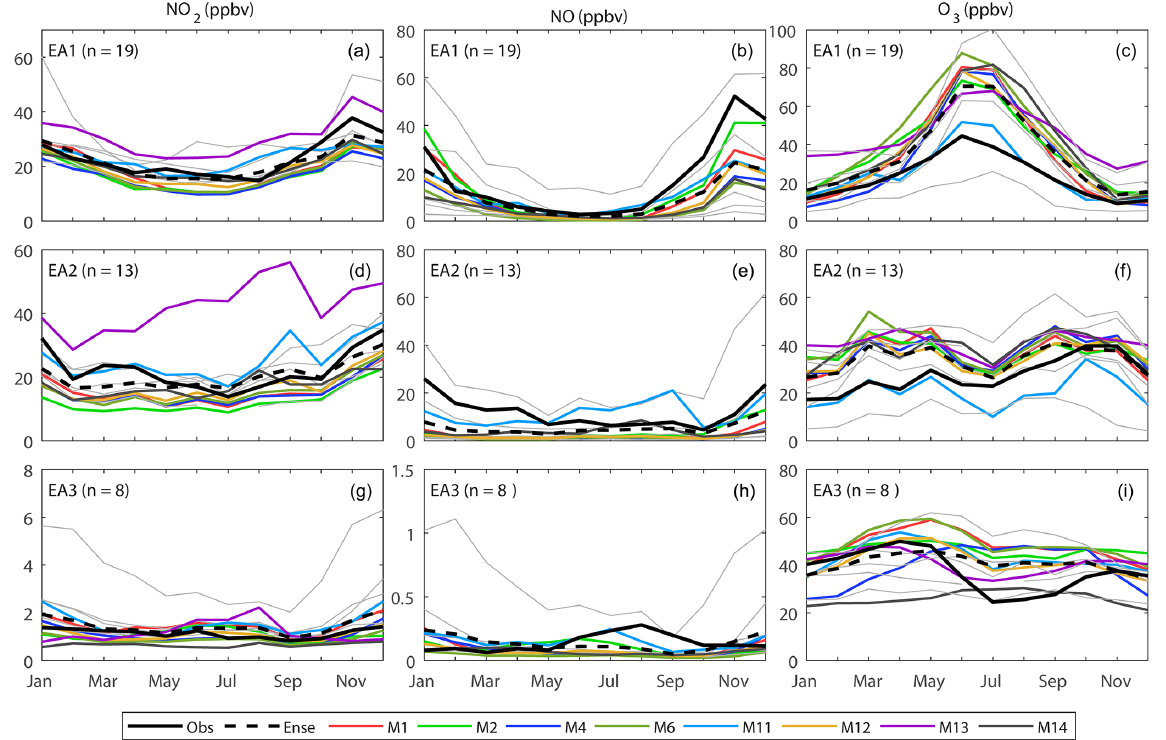
Figure 3. Time series of monthly NO 2 , NO and O 3 levels simulated by all models and their ensembles (Ense) in parts per billion by volume (ppbv), averaged over all observed stations across three subregions of East Asia: EA1 (a–c) , EA2 (d–f) and EA3 (g–i) . Observations are denoted by the solid black line. n represents the number of stations. The gray lines represent NO 2 , NO and O 3 levels simulated by models except M1, M2, M4, M6, M11, M12, M13 and